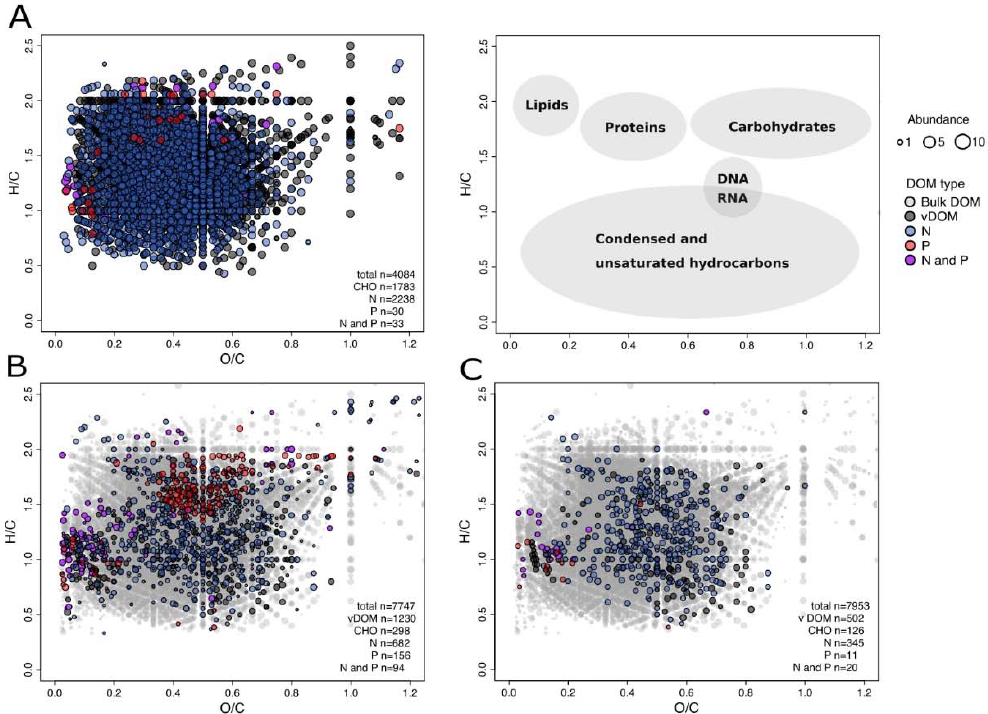
Figure 4. Distribution of the detected DOM molecular formulas over the course of the experiment (day 0 until day 55) of the mitomycin C treated slurry of the 20 cmbsf incubation according to the H / C and O / C ratios (van Krevelen diagram). Each dot represents at least one molecular formula, color-coded according to the N- and P-content and locations of typical molecular compound classes [57] are indicated (see legend). ( A ) Background DOM compounds, identified at day 0, ( B ) freshly released DOM compounds after virus-mediated cell lysis on day 6 (vDOM) and ( C ) remaining vDOM compounds at the end of the experiment are displayed. In B and C, background DOM compounds that were not associated with the virus-induced cell lysis are presented in